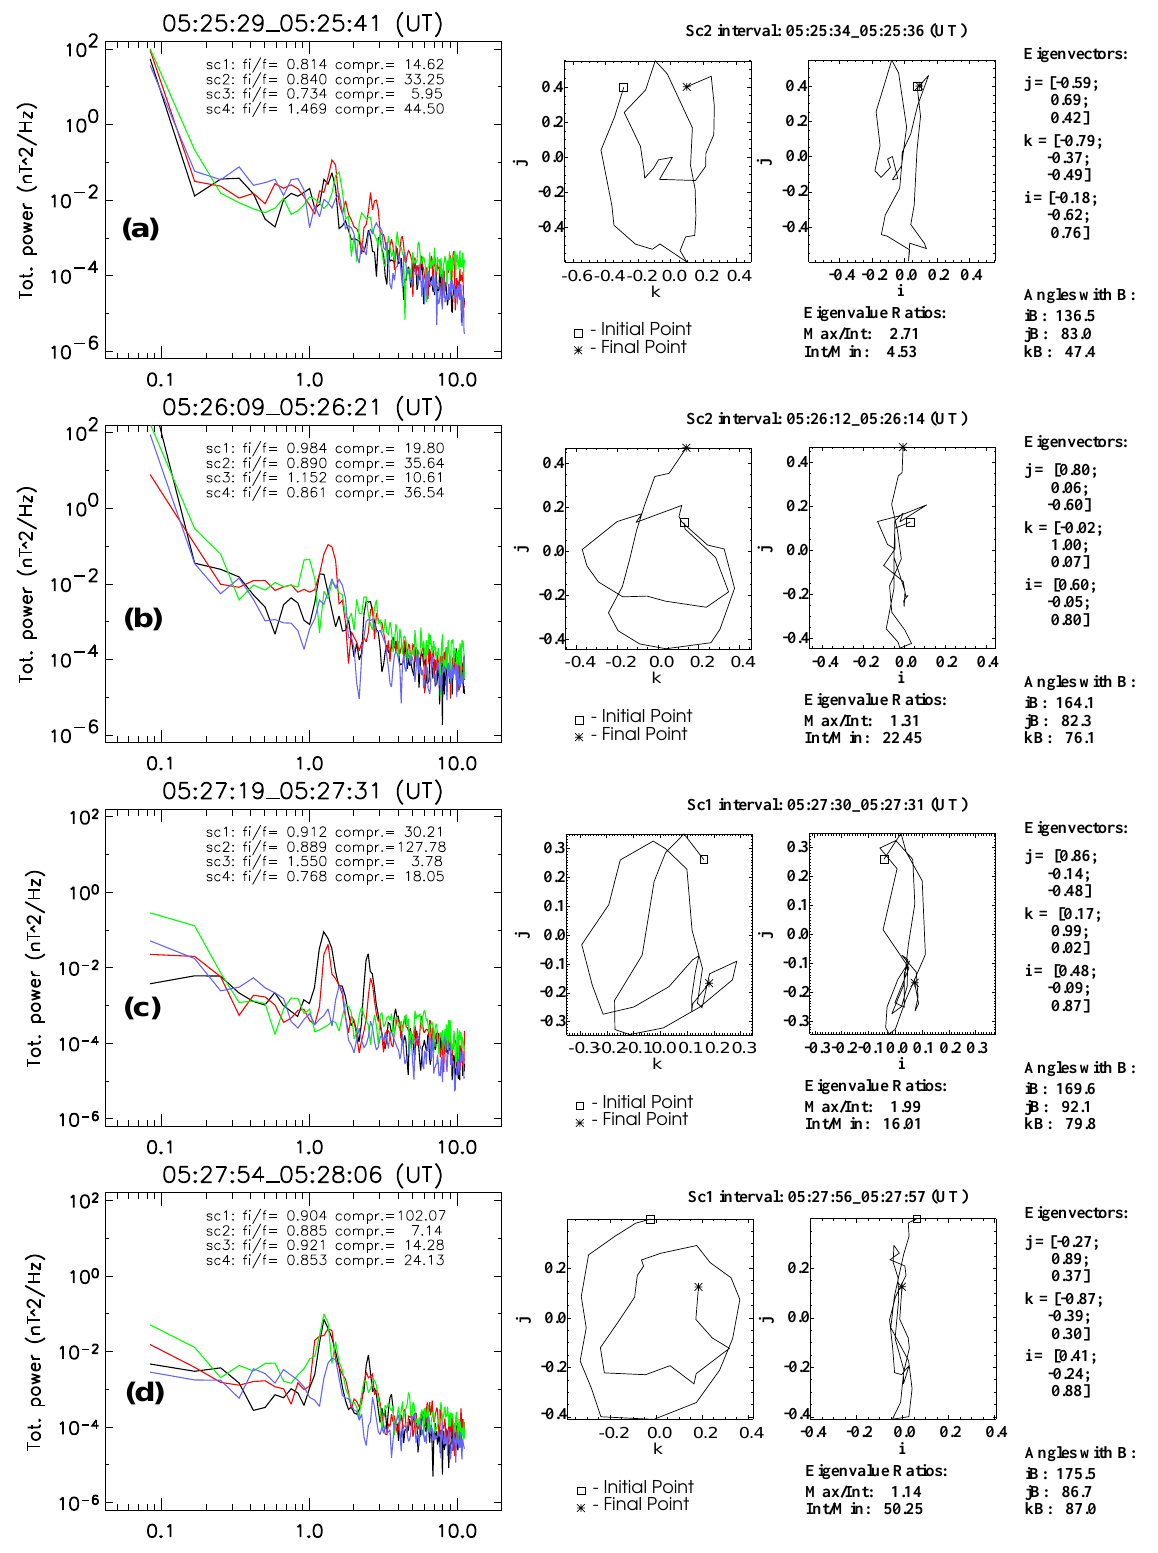
Fig. 10. Total power of magnetic field fluctuations (left) at 05:25:29–05:25:41 (a) , at 05:26:09–05:26:21 (b) , at 05:27:19–05:27:31 (c) and at 05:27:54–05:28:06 (d) . Hodograms of the wave magnetic field (right) observed by SC2 beteeen 05:25:34–05:25:36 (a), betweeen 05:26:12–05:26:14 (b), and by SC1 between 05:27:30–05:27:31 (c) and at 05:27:56–05:27:57